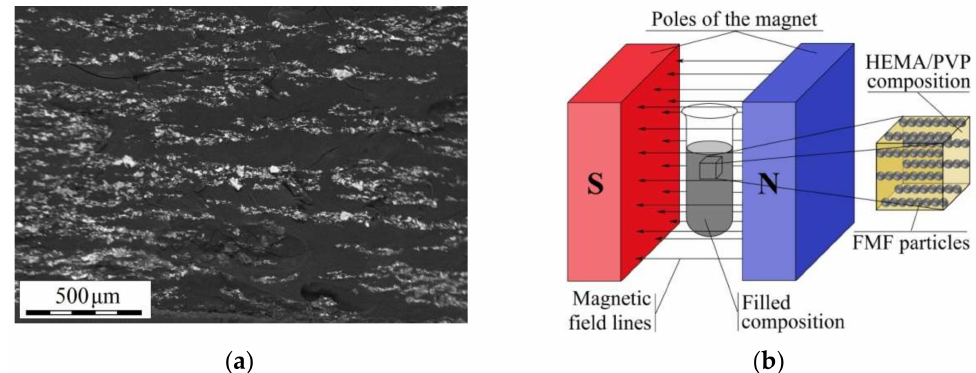
Figure 13. SEM micrographs of Co-filled pHEMA-gr-PVP copolymer with uniaxially ordered particles ( a ) and obtainment process scheme of a composite hydrogel in a magnetic field ( b ).